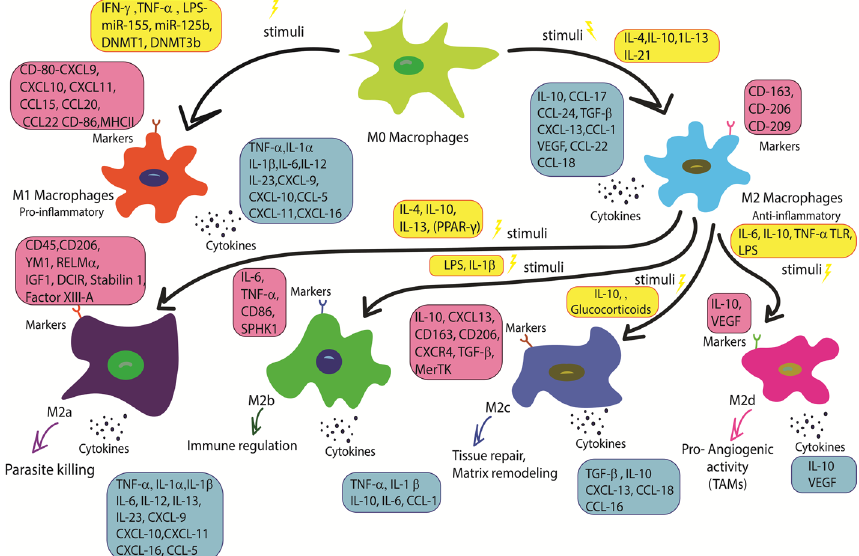
Fig. 1 Macrophage polarization phenotypes and subtypes according to their different characteristics have many roles in immune responses. M1 macrophages have a pro-inflammatory role by their cytokines, but M2 macrophages, which are divided into four subtypes, have many different roles. For example, M2a macrophages play an important role in parasite killing, M2b macrophages function as immune system regulators, M2c macrophages assist in the wound healing process, and M2d macrophages have a pro-angiogenic role and are very important in tumor progression. CCL, C–C chemokine ligand;